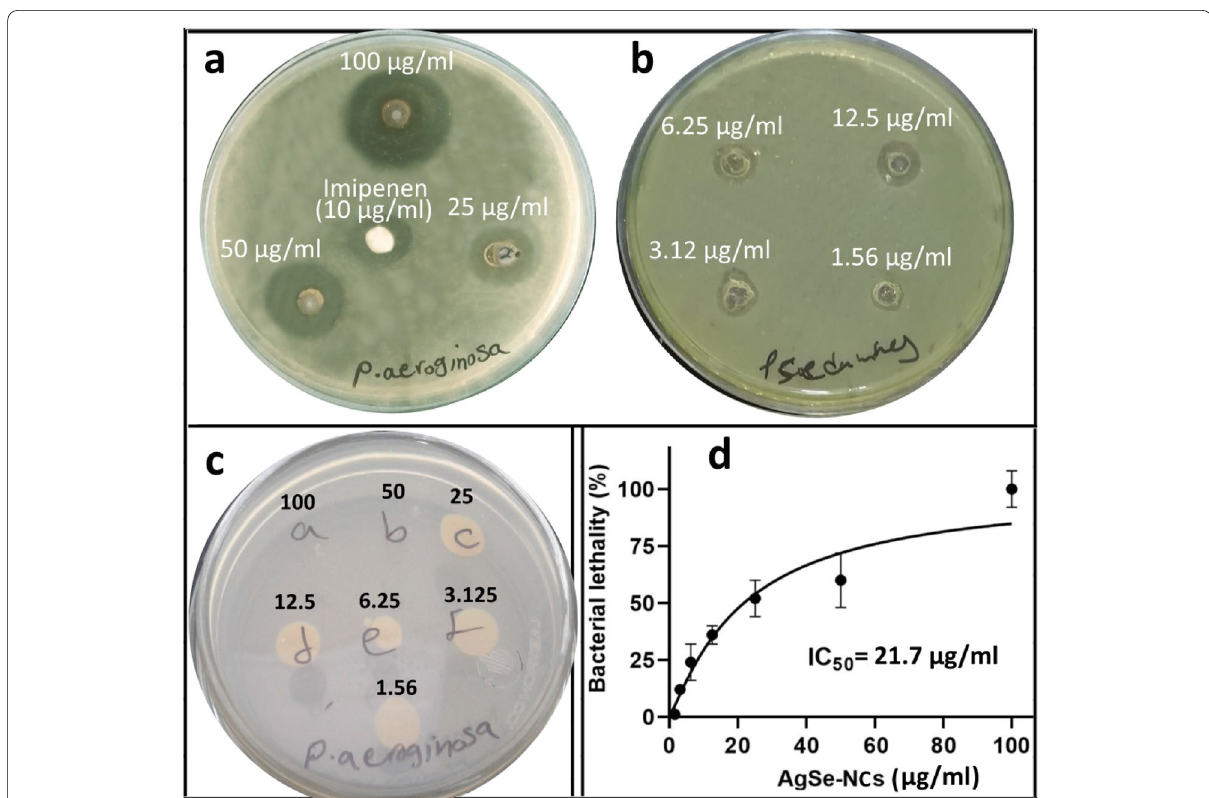
Fig. 5 Antimicrobial studies of Ag 2 Se-NCs against P. aeruginosa (ATCC 27853) at different concentrations (1.56–100 µg/ml). a , b Agar well-diffusion assay, c MBC on the agar plate and d IC 50 value in terms of MIC